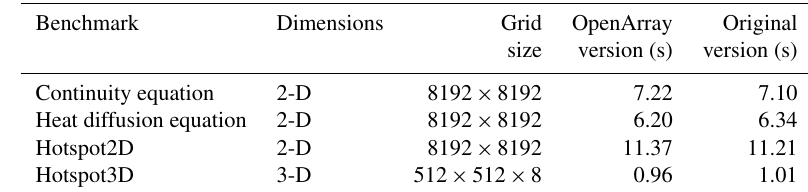
Table 5. Four benchmark tests.